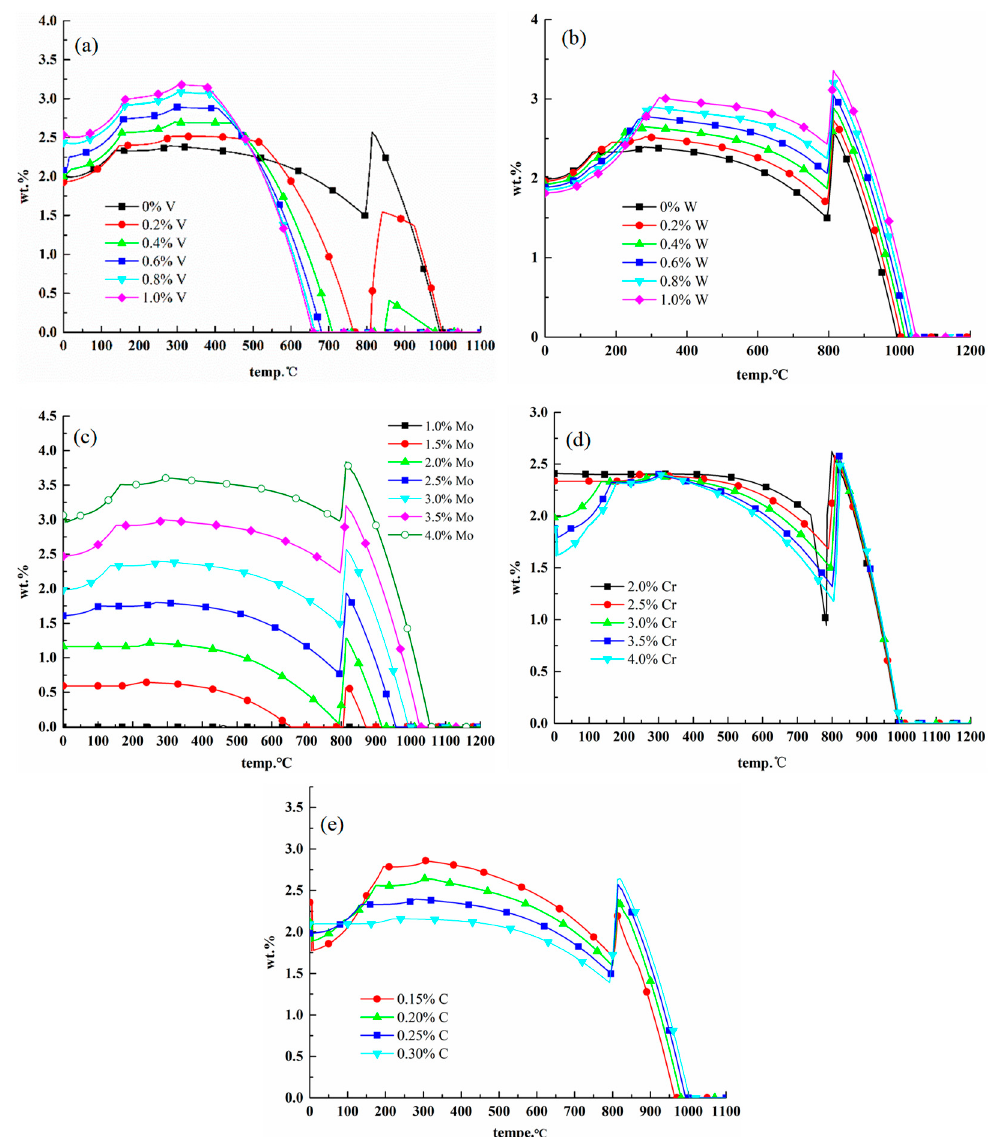
Figure 4. E ff ects of alloying elements on M 6 C carbides. ( a ) E ff ect of V on M 6 C; ( b ) e ff ect of W on M 6 C; Figure 4. Effects of alloying elements on M 6 C carbides. ( a ) Effect of V on M 6 C; ( b ) effect of W on M 6 C; ( c ) e ff ect of Mo on M 6 C; ( d ) e ff ect of Cr on M 6 C; ( e ) e ff ect of C on M 6 ( c ) effect of Mo on M 6 C; ( d ) effect of Cr on M 6 C; ( e ) effect of C on M 6 C.